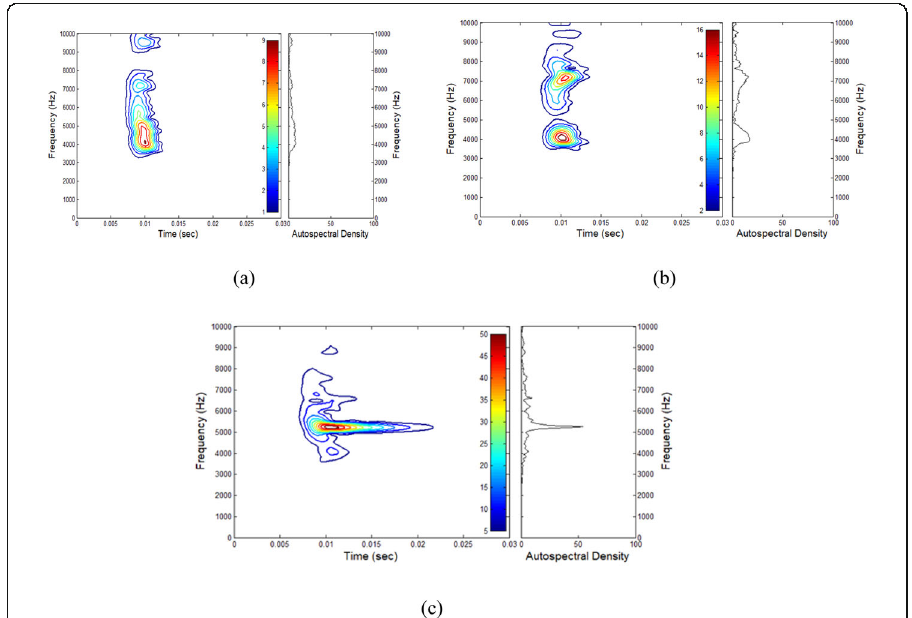
Fig. 4 Test result graph according to adhesion condition: a Fully bonded state. b Debonded state. c Cavity existence and abnormal